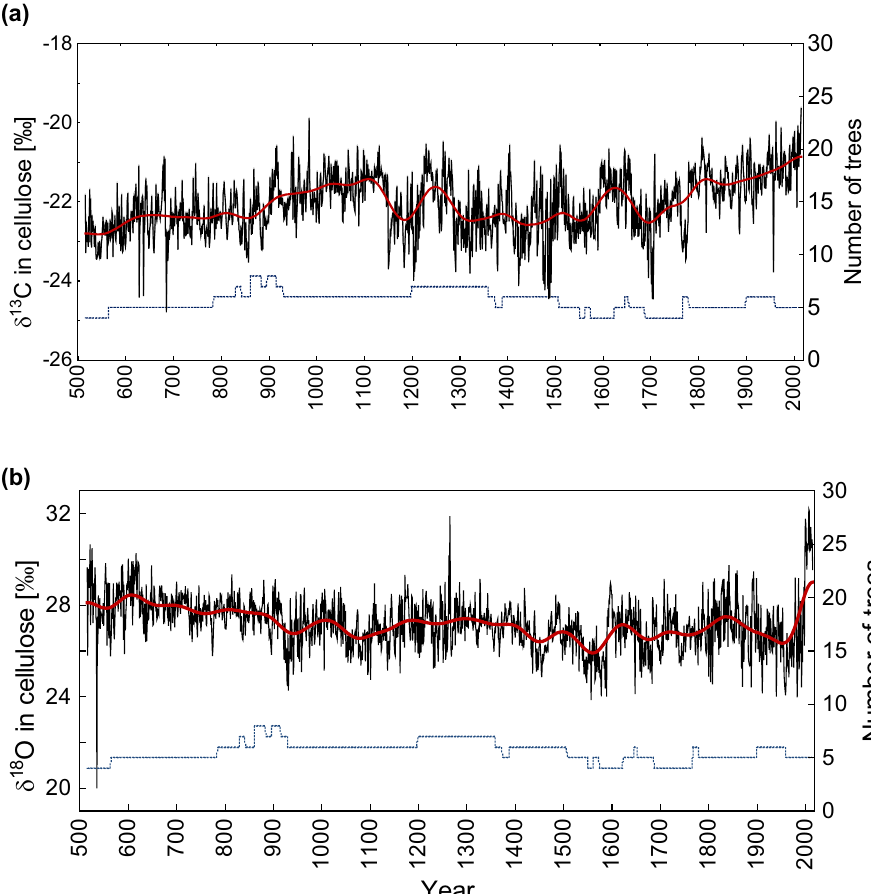
Figure 1. Annually resolved δ 13 C cell ( a ) and δ 18 O cell ( b ) in Siberian larch tree-ring cellulose chronologies for the period from 516 to 2016 CE. Chronologies are smoothed by a 101-year Hamming window to highlight a centennial scale. The dotted and dashed lines indicate the number of trees